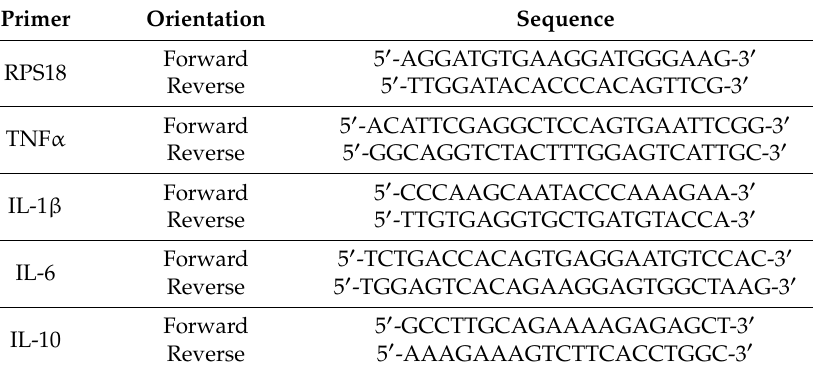
Table 1. Primers used for quantitative real-time PCR.